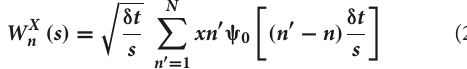
( Supplementary Table 1 ) and gap-filling methods are described in Supplementary material